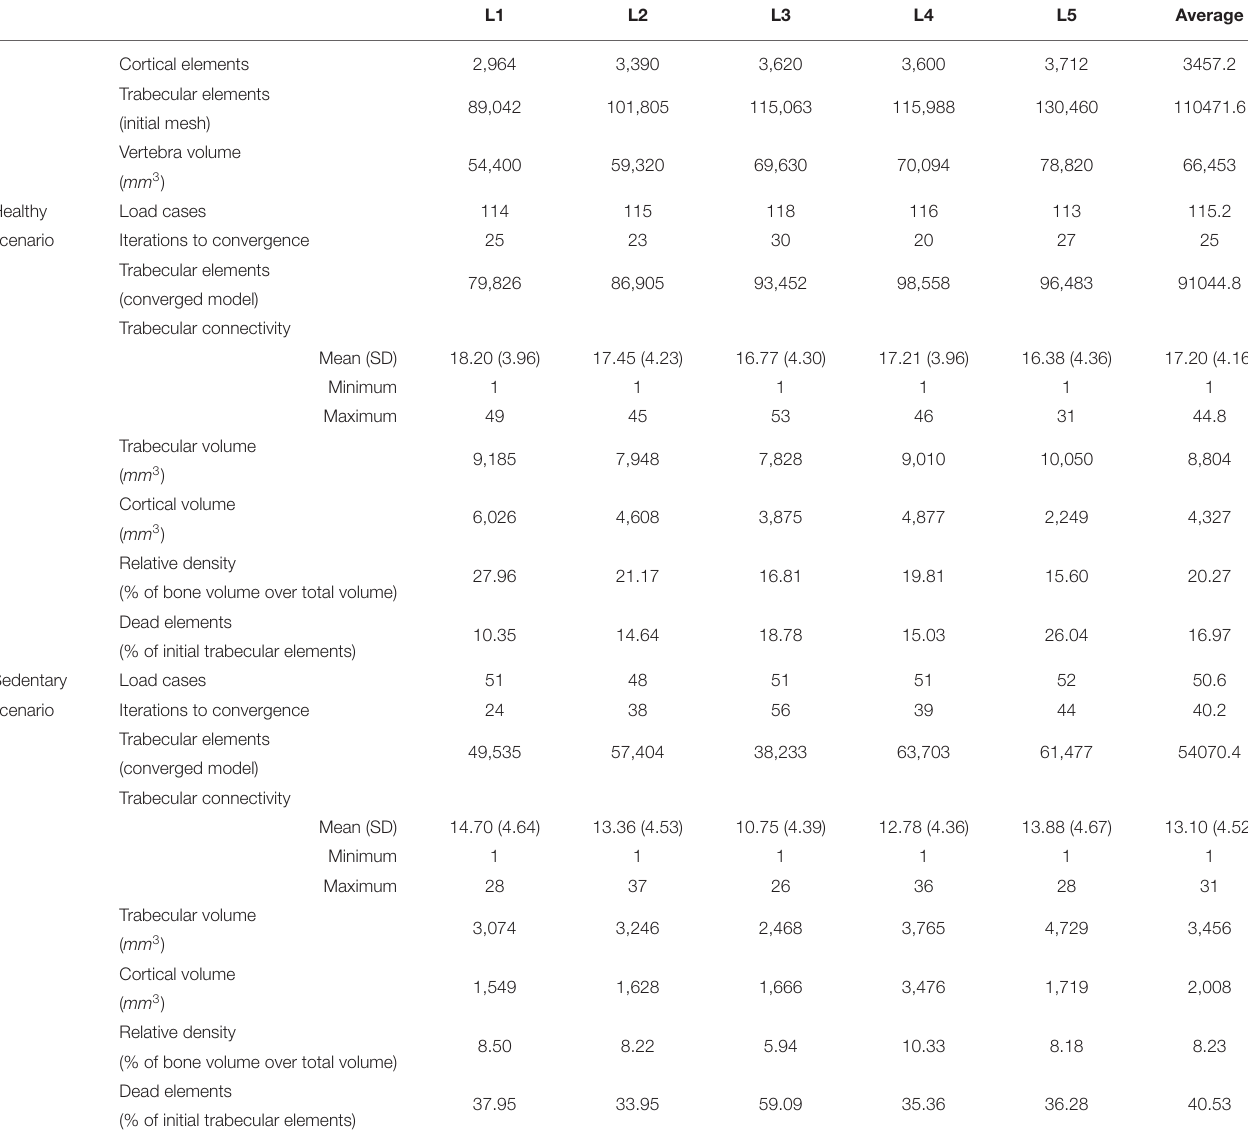
TABLE 2 | Characteristics of the converged mesoscale structural finite element models after adaptation to the healthy and sedentary